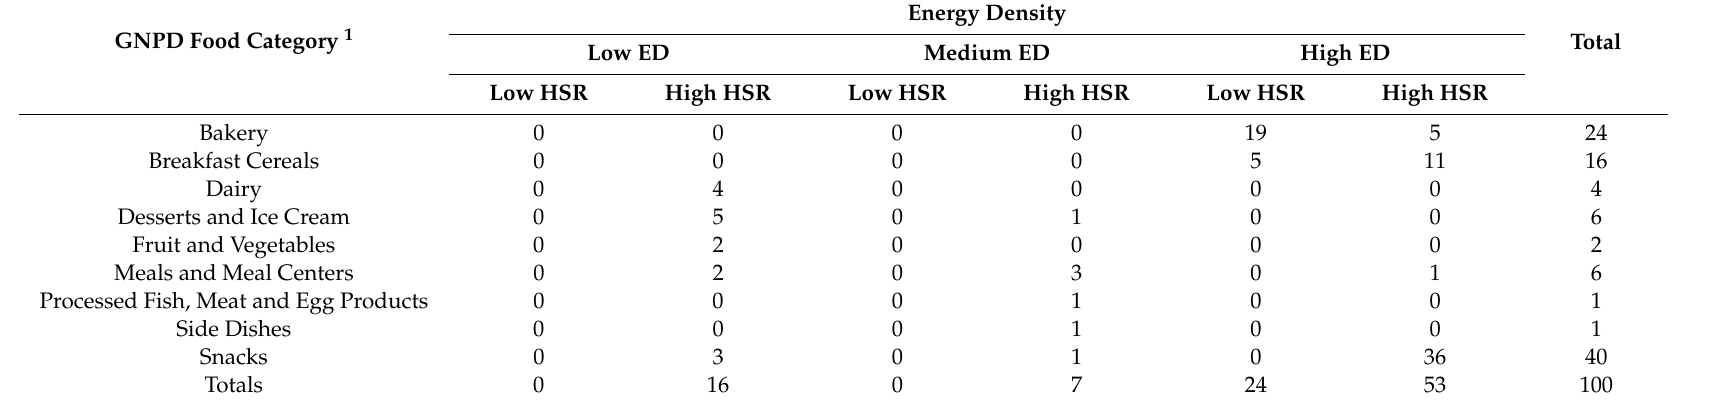
Table A1. Number of products by energy density (ED) and Health Star Rating (HSR)